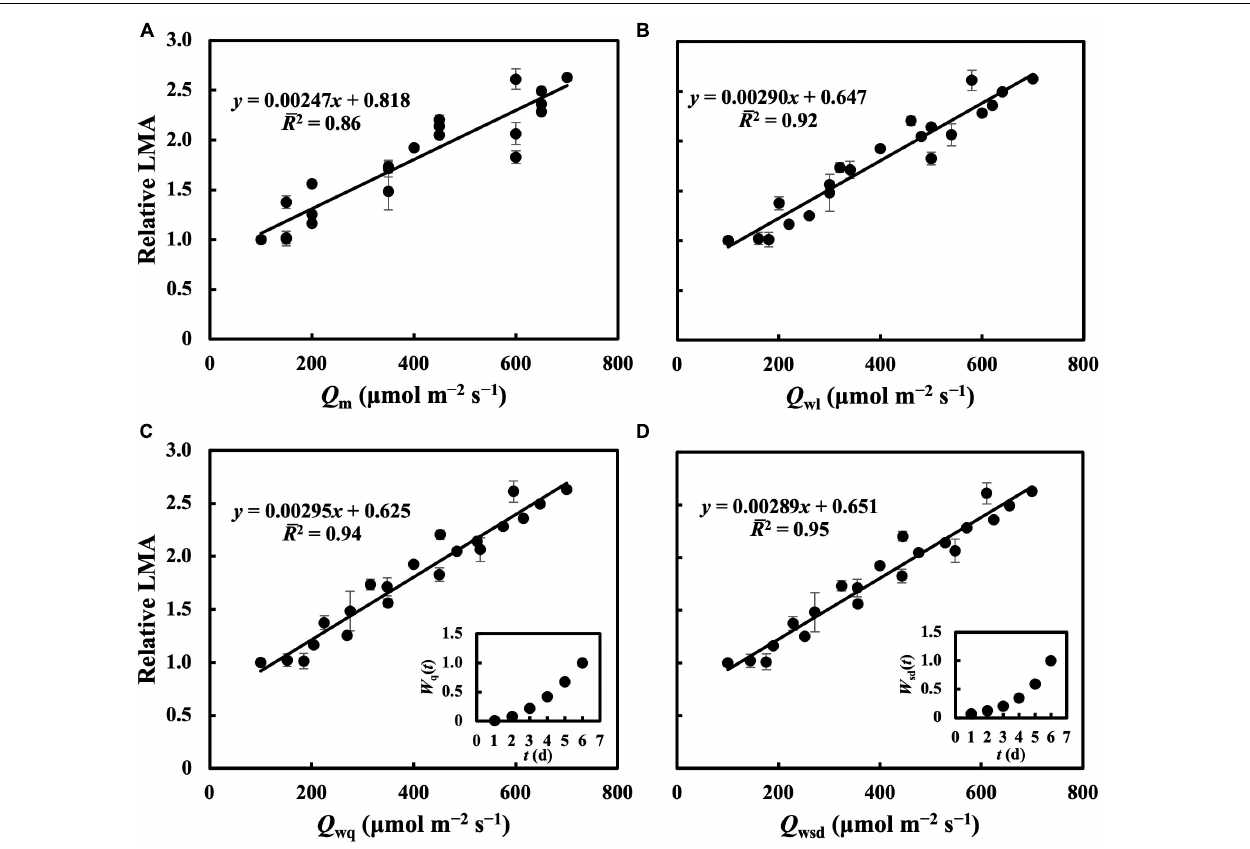
FIGURE 3 | Linear regression of relative LMA on Q m (A) , Q wl (B) , Q wq (C) , Q wsd (D) . First true leaves of cucumber seedlings were acclimated to treatments in which 1 day had a PPFD level from basal PPFD levels in other 5 days in the second experiment. All values were means ± standard errors ( n = 3) and relativized to that for 100 µ mol m − 2 s − 1 . Regression lines, regression functions, and R 2 are shown. Corresponding weights of Q wq [ W q ( t )], Q wsd [ W sd ( t )] in t day which achieved the minimum RMSEs of estimation of LMA are shown.